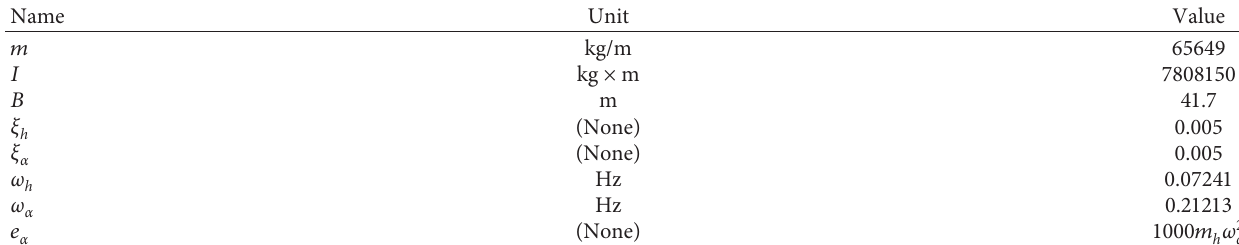
Table 1: Parameters of the bridge flutter system.